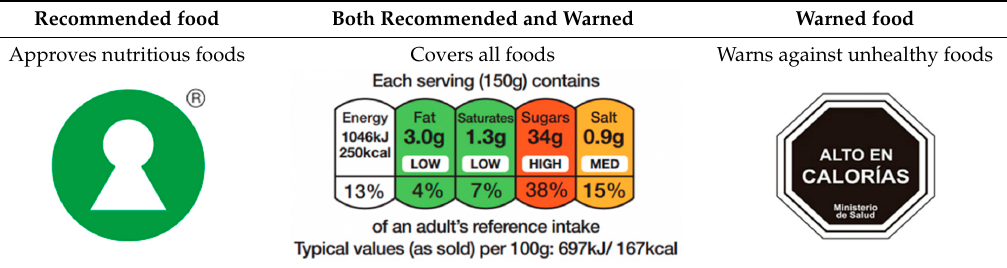
Table 3. Description and examples of FoPLs according to their Gradation.